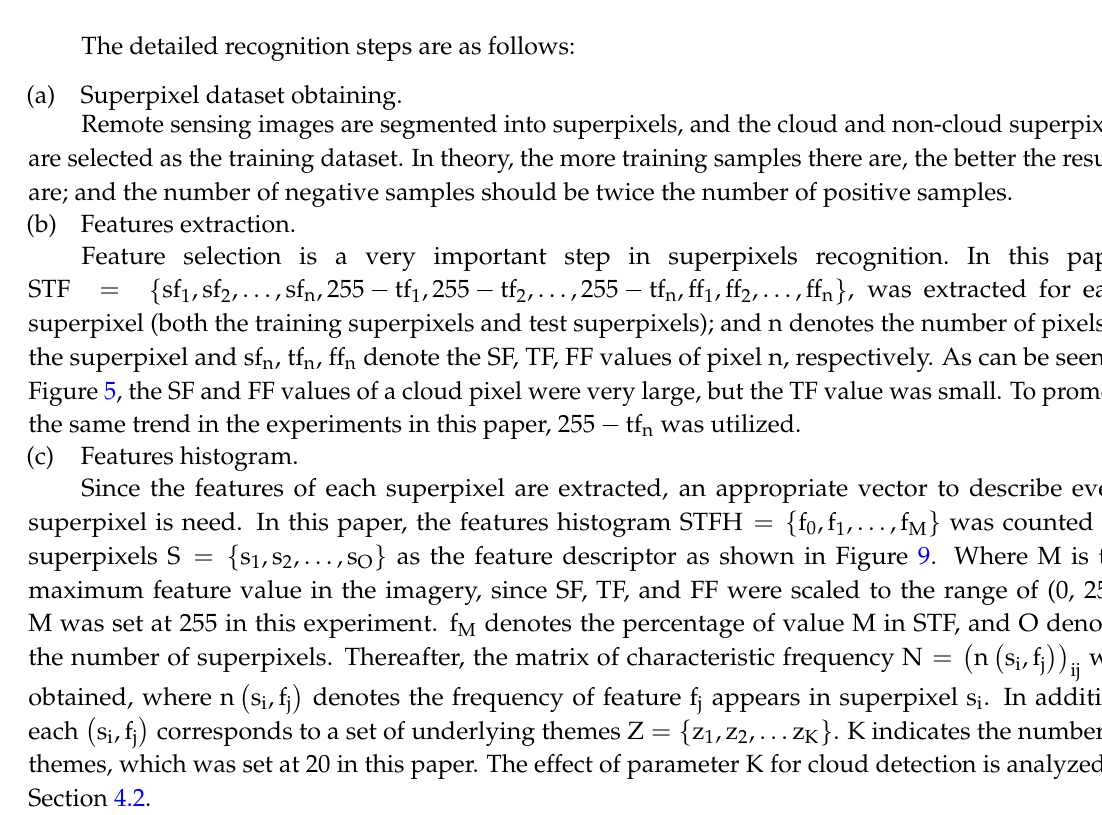
Figure 8. Flow chart of cloud mark extraction.